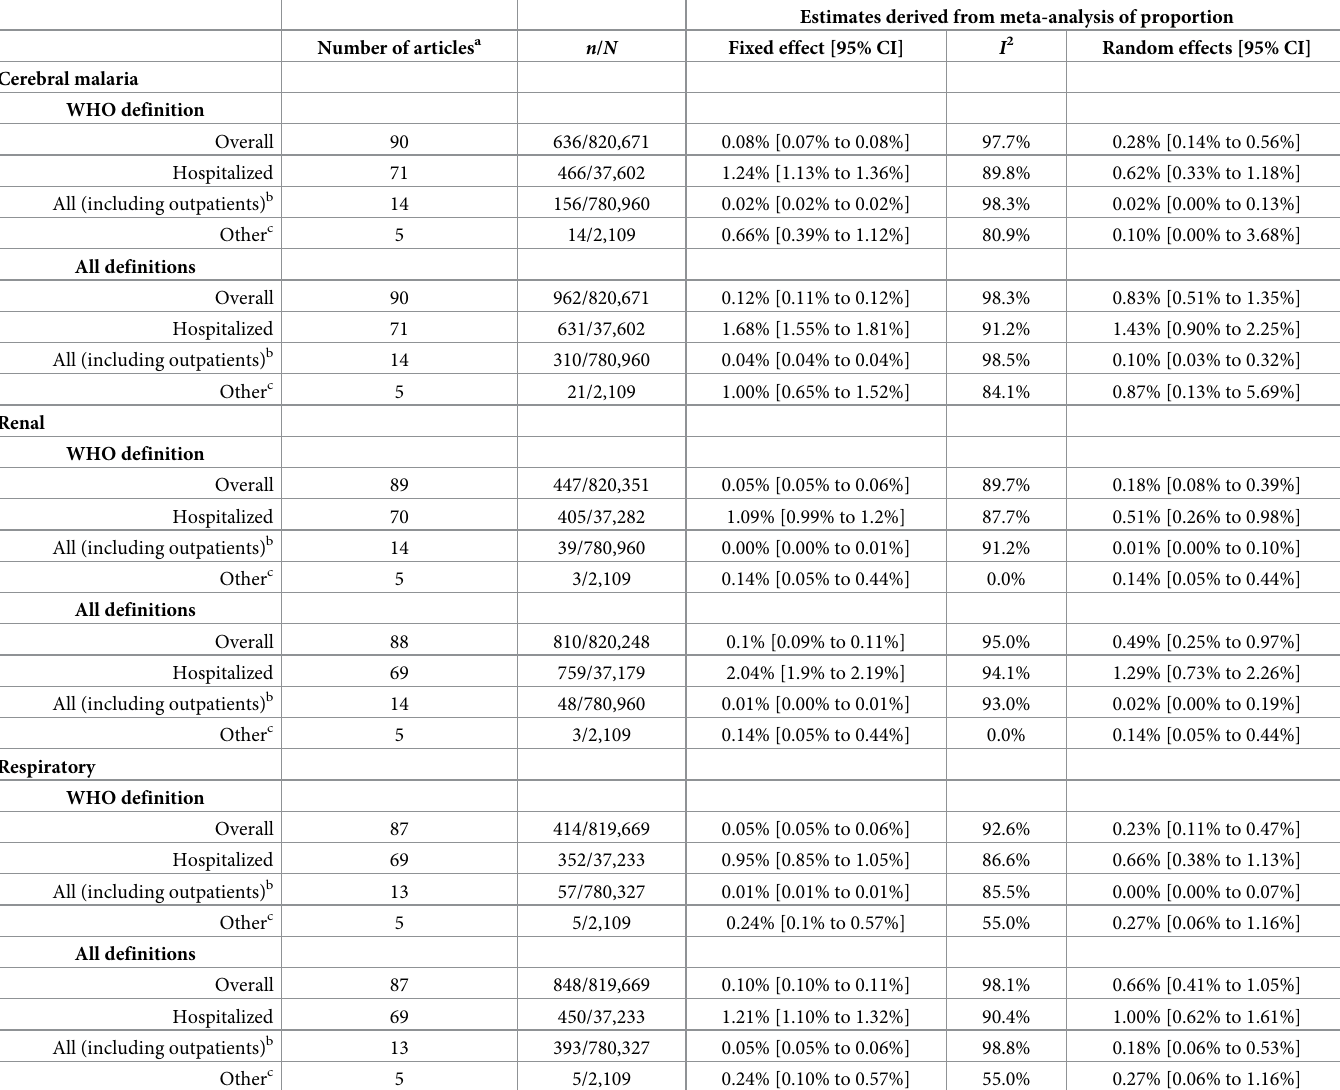
Table 3. Estimating proportion of patients with cerebral malaria, renal complications, and respiratory complications in studies eligible for inclusion in the meta-